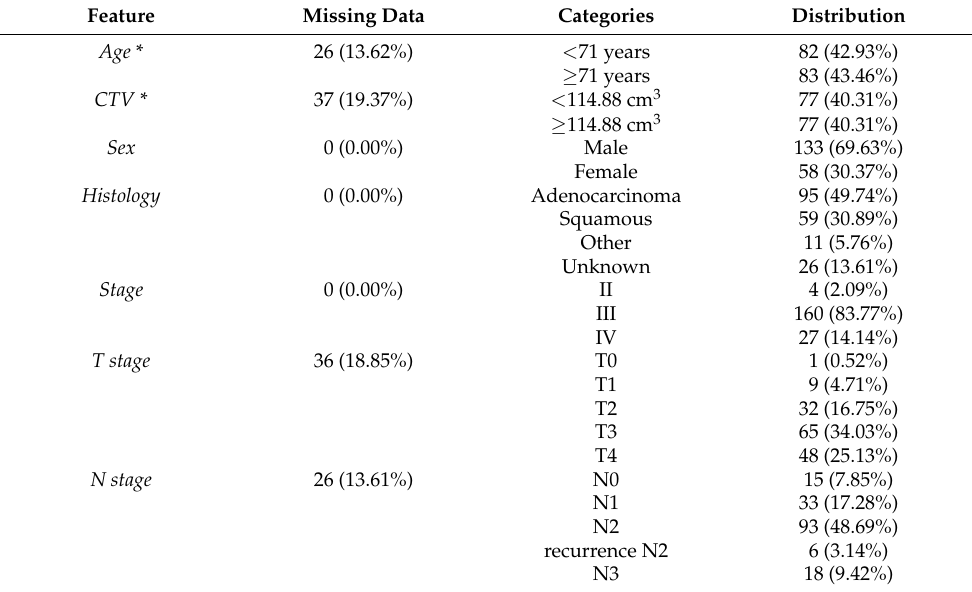
Table 2. Patients’ characteristics. As marked by *, note that, although age and CTV are continuous variables, for the sake of synthesis we report here their distribution considering their median values as thresholds, whilst the model used the continuous values. The division into stages is further defined by letters (a, b, and c), which are not reported for the sake of brevity, but the model uses the actual